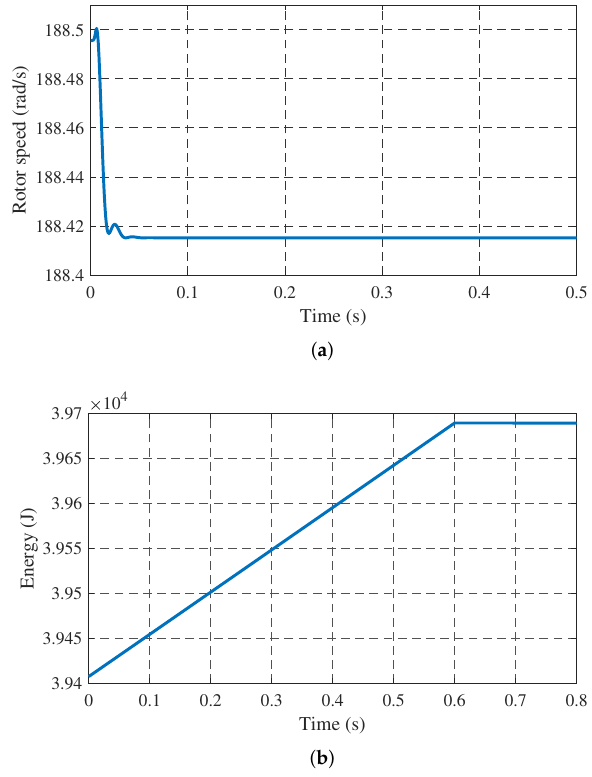
Figure 9. ( a ) Rotor speed and ( b ) energy stored by the flywheel system.